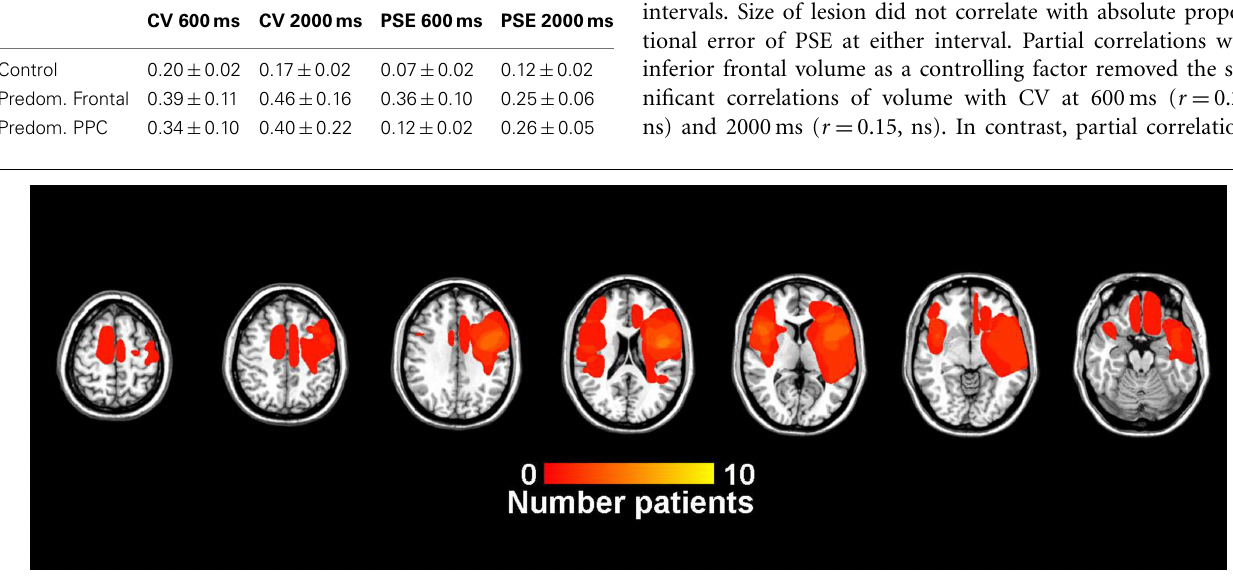
Table 4 | Performance of controls versus patients with predominantly frontal lesions and those with predominantly posterior parietal lesions.